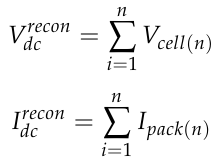
Figure 6. Control signal sensor fusion module.